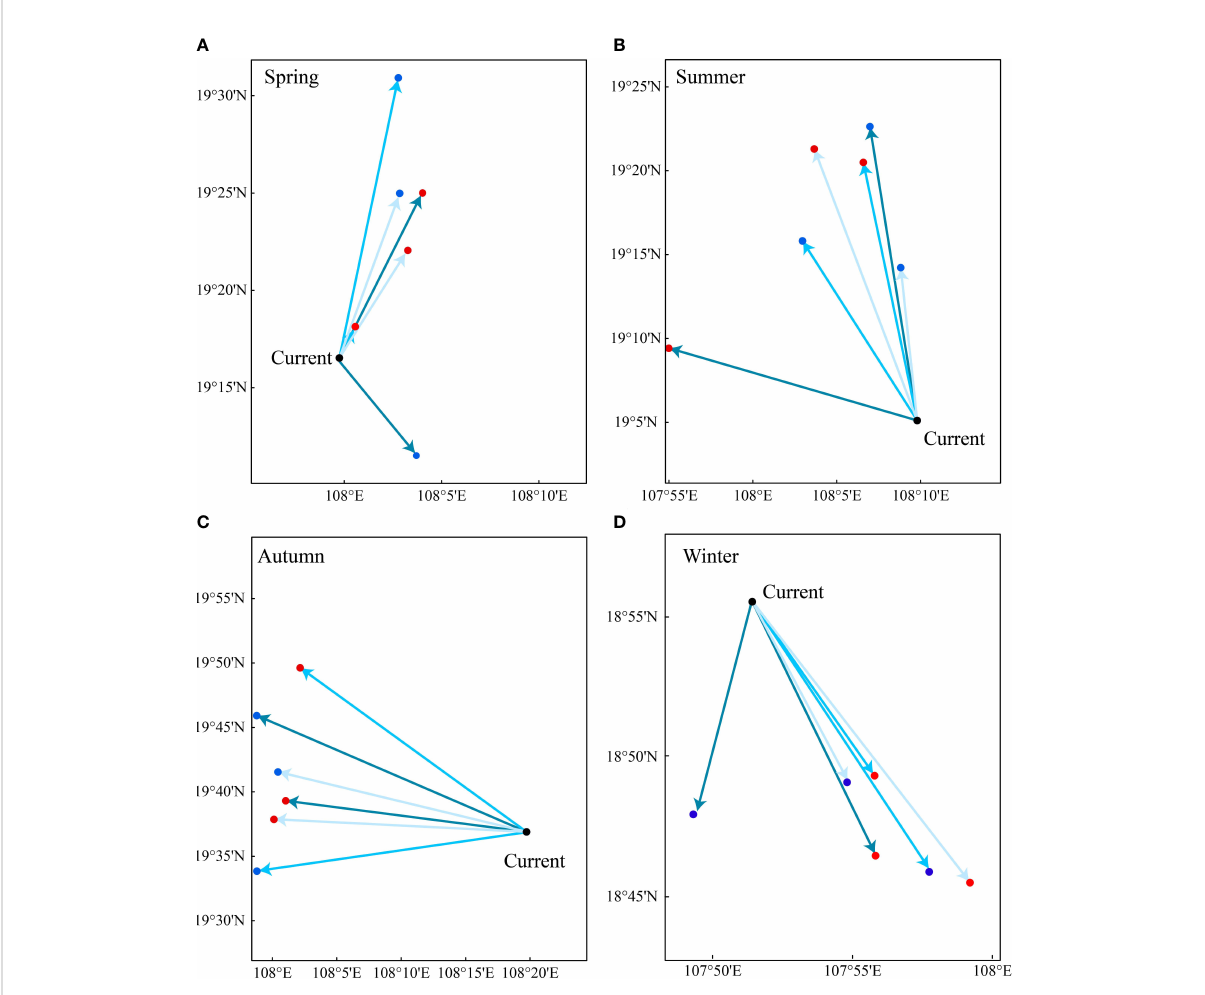
FIGURE 9 Current potential distribution pattern of Trichiurus japonicus in the Beibu Gulf, by season, and core distributional shifts of suitable habitat under future climate scenarios in the 2050s and the 2090s. Different colors represent different climate-change models: dark blue denotes SSP126, mid-blue SSP370, and light blue SSP585. The black dot represents the suitable habitat distribution center under the current climate scenario, blue dots represent that in the 2050s, and red dots that in the 2090s; red arrows indicate shifting routes of the suitable habitat distribution core. (A) spring; (B) summer; (C) autumn; (D)